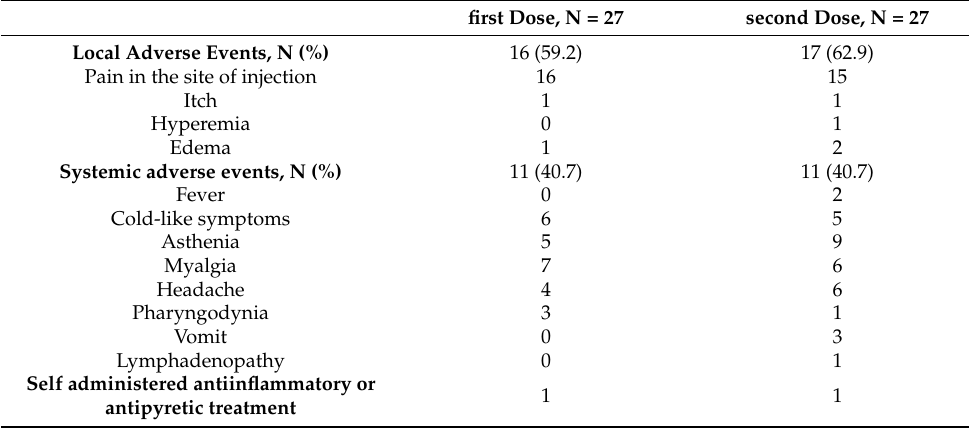
Table 2. Adverse reactions in pIBD